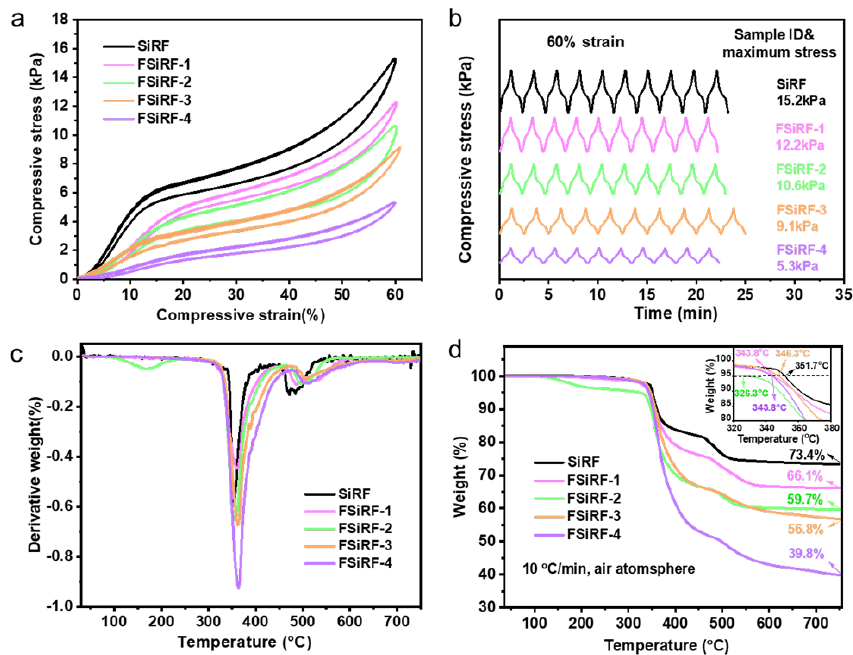
Figure 4. Mechanical and thermal properties of FSiRF samples. ( a ) Compressive stress − strain curves of the FSiRF materials with different fluorine content at strain = 60%, and ( b ) compression cycle tests at strain = 60% of various FSiRF samples, demonstrating the mechanical stability of the materials.